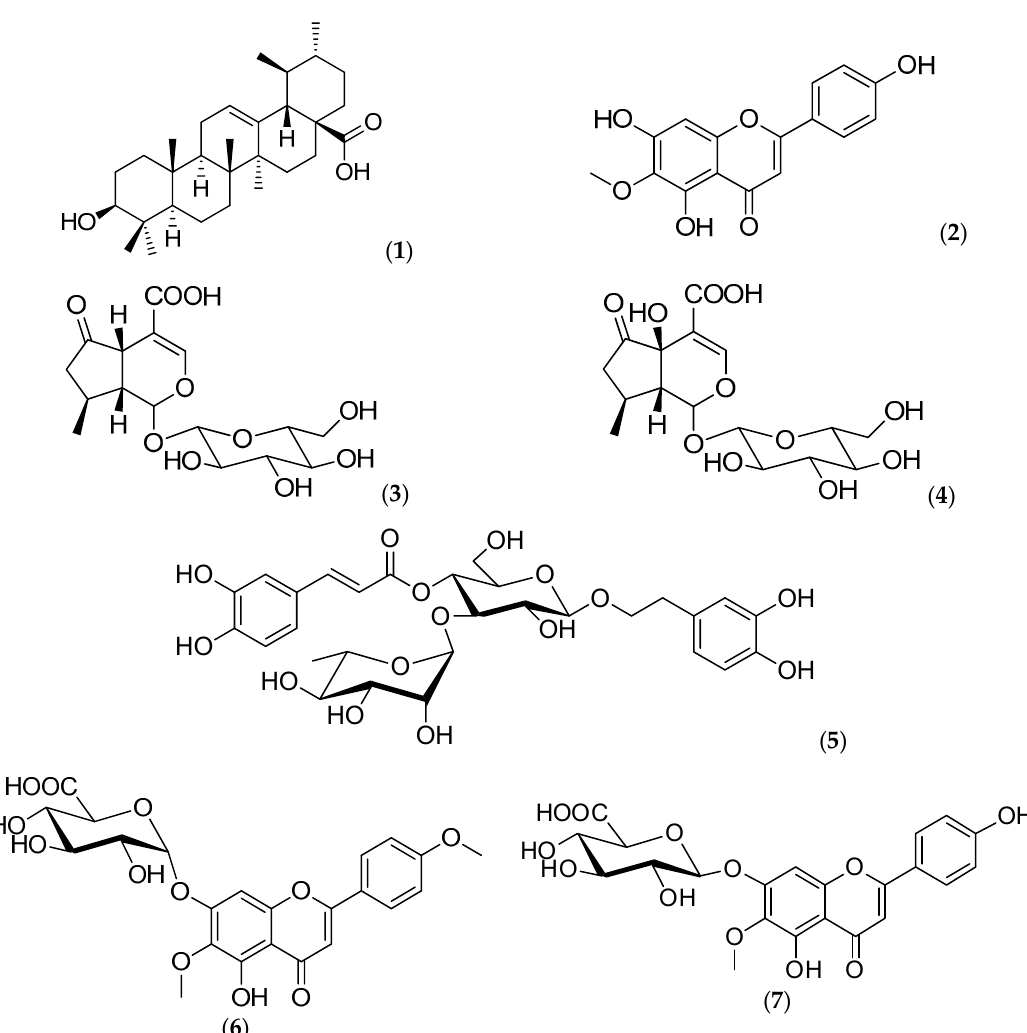
Figure 1. Chemical structures of compounds isolated from V. carolina . Ursolic acid (1), hispidulin (2), verbenaline (3), hastatoside (4), verbascoside (5), hispidulin 7- O - β - D -glucuronopyranoside (7O β GH, (6)), pectinolaringenin-7- O - α - D -glucuronopyranoside (7).